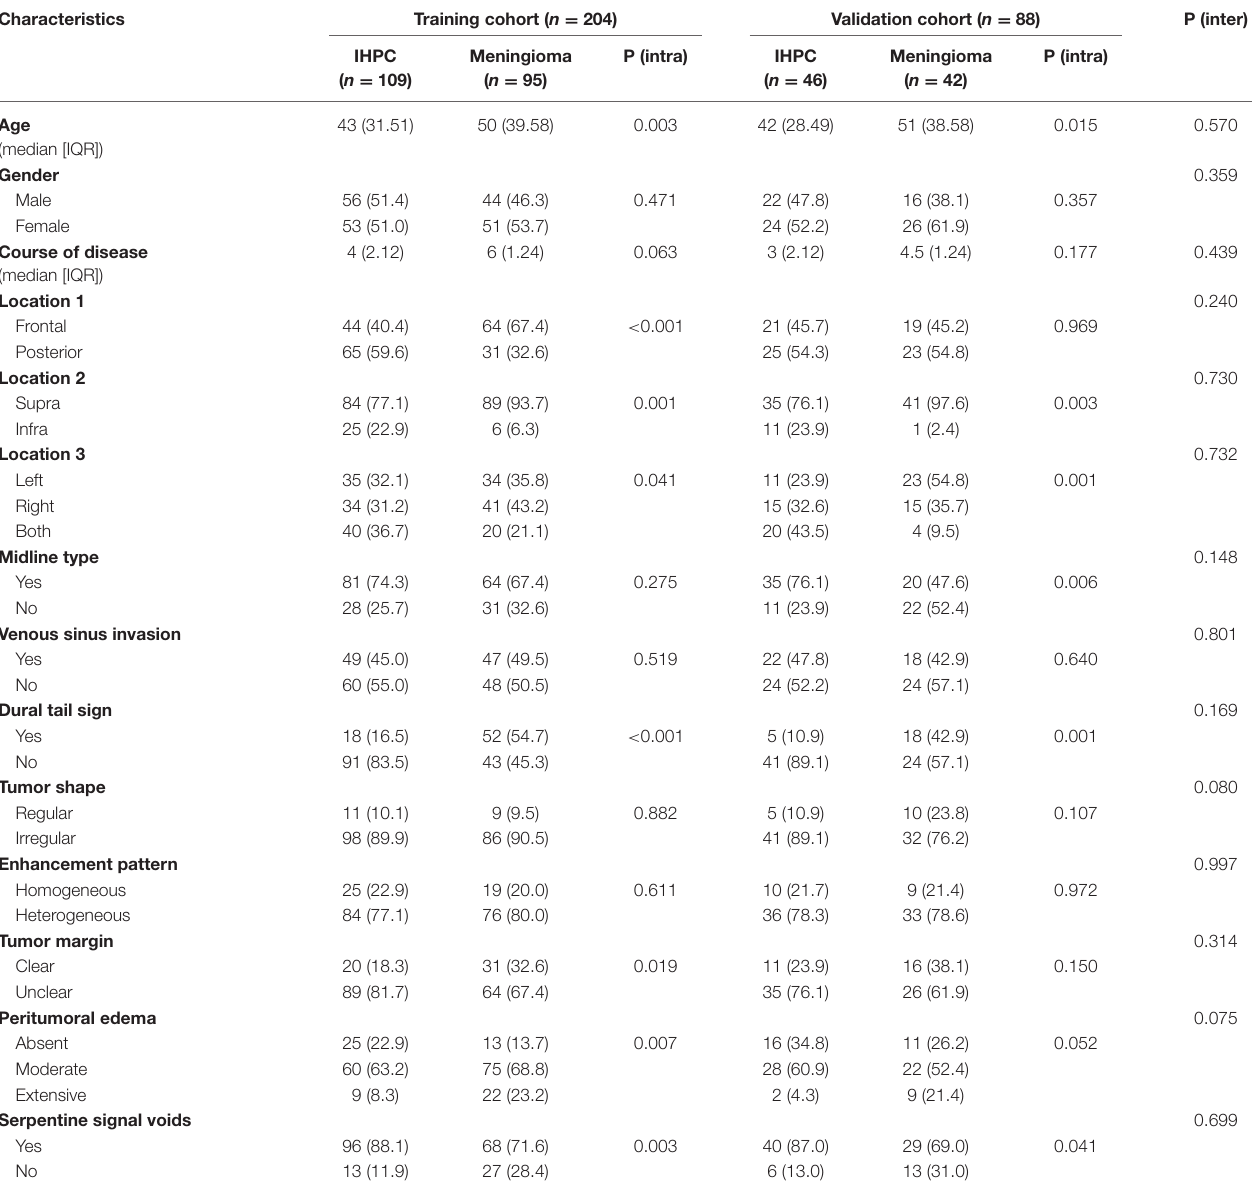
TABLE 1 | Baseline characteristics in training and validation